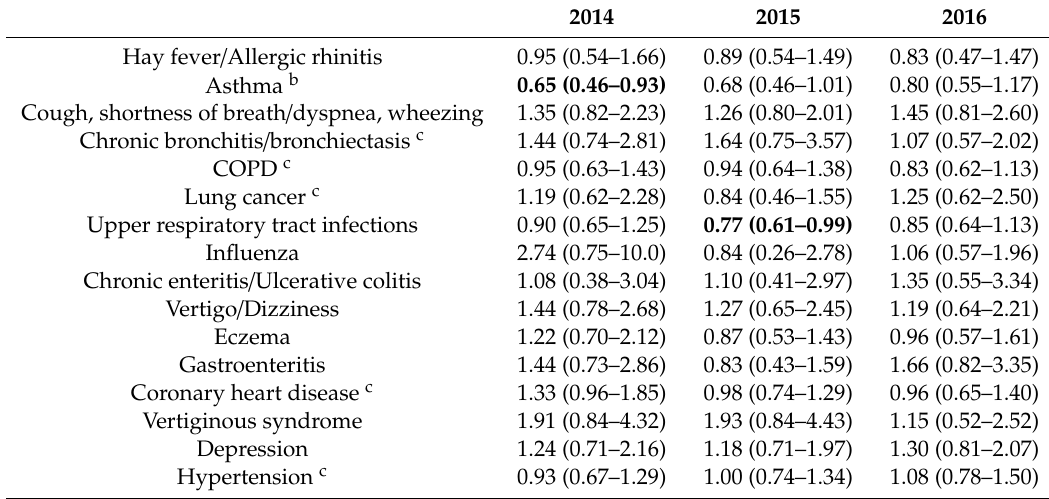
Table 2. Differences (OR, 99% CI) a per year in various comorbid conditions between livestock dense areas and control areas among patients with pneumonia (total sample) (statistically significant results in bold)